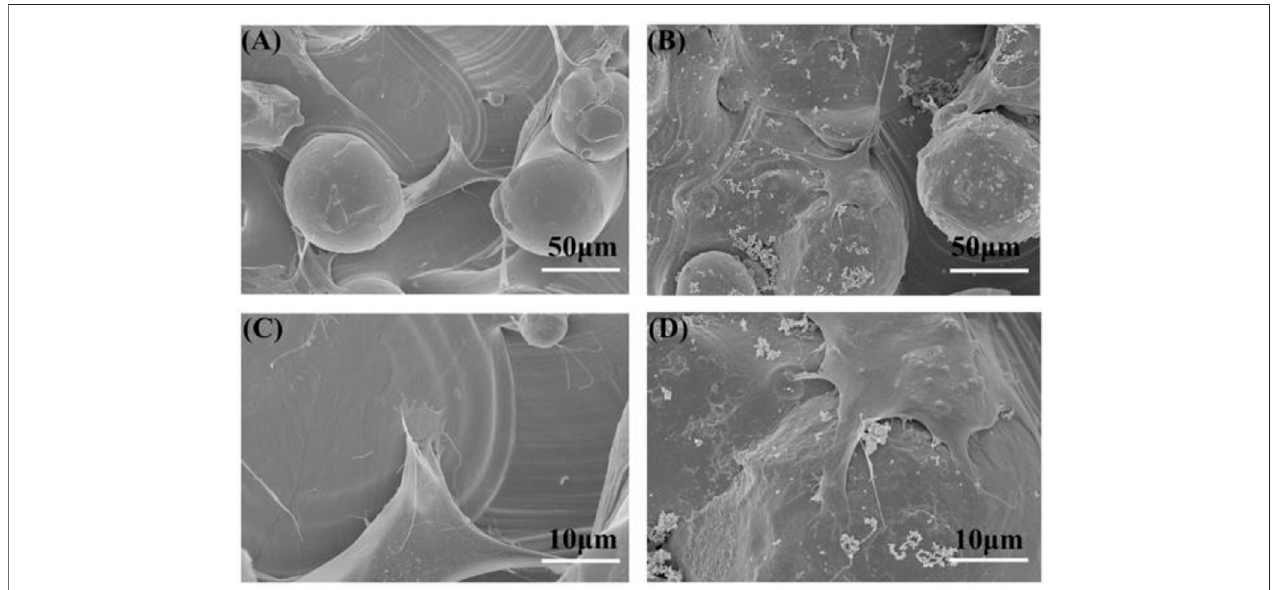
FIGURE 2 | SEM images of adherent cells on the 3D (A,C) and 3D-PDA (B,D) samples after 24 h of culture at low (A,B) and high (C,D) magni fi cations.